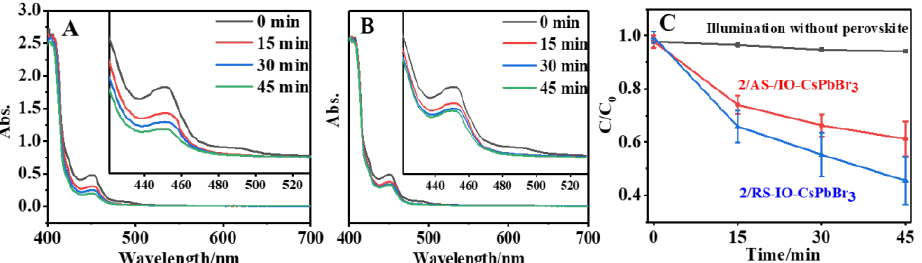
Figure 6. Time-dependent UV/Vis spectra of the photocatalytic reaction over 2/AS-IO-CsPbBr 3 ( A ) and 2/RS-IO-CsPbBr 3 ( B ). Time-dependent relative concentration of TerEDOT in the supernate in the presence of 2/AS-IO-CsPbBr 3 (blue), 2/RS-IO-CsPbBr 3 (red) and in absence of photocatalysts (black) ( C